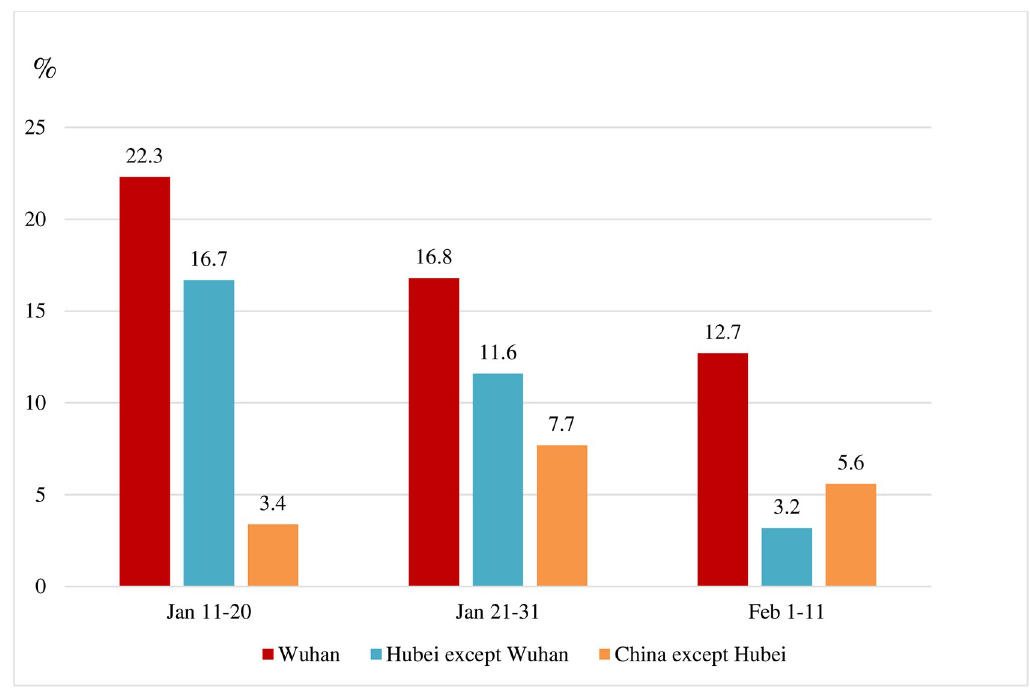
Fig 1. Percentage of healthcare infected workers in severe conditions by dates of symptoms onset and regions in China.